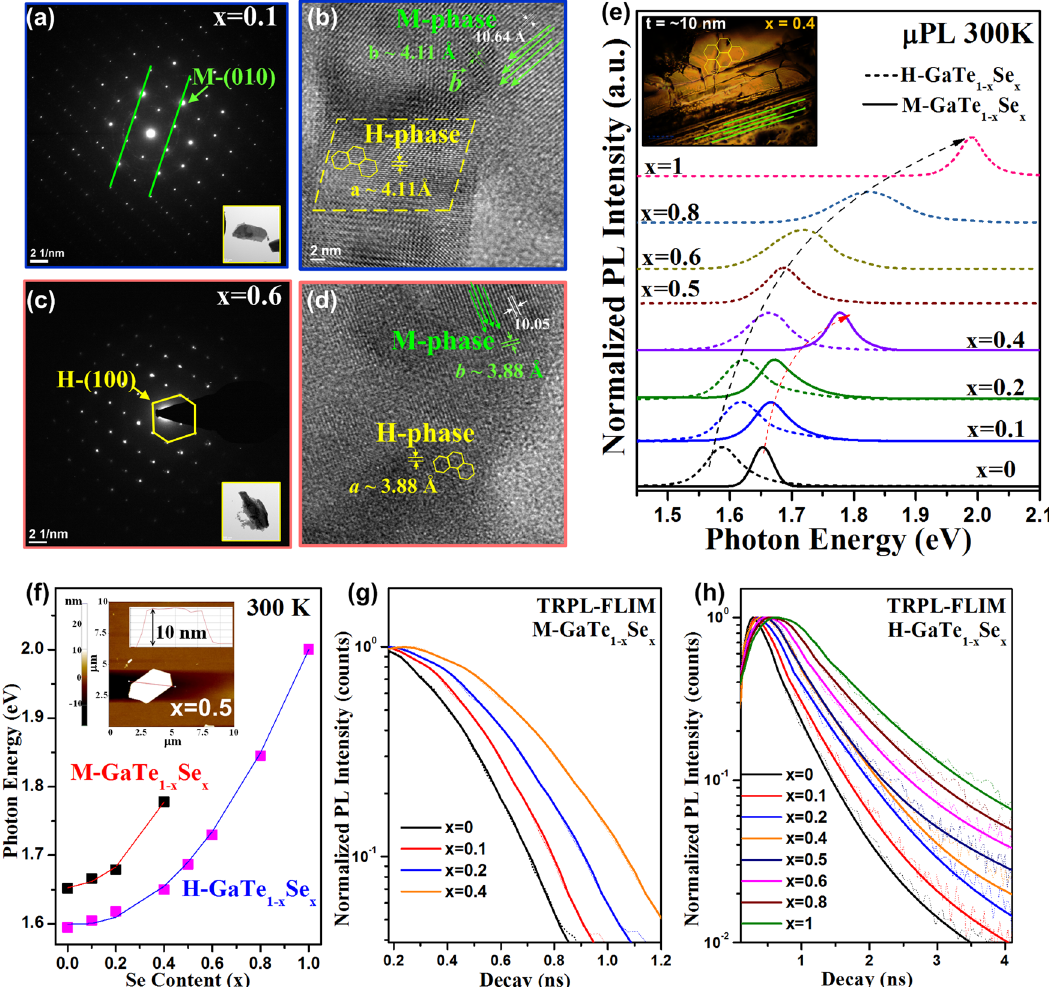
Fig. 1 Structure, μ PL and TRPL properties of M- and H-GaTe 1-x Se x . a SAED pattern and ( b ) HRTEM image of a selected few-layer GaTe 0.9 Se 0.1 . The inset shows the nano fl ake sample used for the HRTEM experiment. c SAED pattern and ( d ) HRTEM image of a selected few-layer GaTe 0.4 Se 0.6 . The inset shows the TEM image of the nano fl ake sample. e µPL spectra of each composition of GaTe 1 − x Se x from x = 0 to x = 1 that were measured for the hexagonal and monoclinic phases at 300 K. The inset shows a microscope image of a selected x = 0.4 nano fl ake ( t ≈ 10 nm) containing H- (hexagonal) and M-phase (line-edge) planes. f Composition-dependent PL peak energies of few-layer M-GaTe 1 − x Se x from x = 0 to x = 0.4 and H-GaTe 1 − x Se x from x = 0 to x = 1. The inset image shows the AFM result of a representative multilayer GaTe 0.5 Se 0.5 sample. g Analysis of the TRPL decay curves of M-GaTe 1 − x Se x from x = 0 to x = 0.4. h Analysis of the TRPL decay curves of H-GaTe 1 − x Se x from x = 0 to x = peaks for H-(002), H-(004), H-(100), H-(102), and H-(107) can be seen to have shifted down to a lower 2 θ angle as the Se content decreased, whereas some XRD peaks for M-(201), M-(401), M-(404), M-(115), and M-(312) gradually shifted up to a higher diffraction angle as the Se content increased from the GaTe end ( x = 0) toward GaSe. Except for GaSe (i.e., pure H phase), the series of GaTe 1 − x Se x (0 ≤ x < 1) layers comprised mixed phases of H and M. Essentially, the H phase was present throughout the entire series of GaTe 1 − x Se x (0 ≤ x ≤ 1) compounds and M phase may or may not have been present in the GaTe 1 − x Se x series with the existence of tellurium (i.e., x ≤ 0.8). The XRD and HRTEM results show that the Se-rich ( x ≥ 0.5) samples had predominantly the hexagonal phase, whereas the dominant phase of the Te-rich crystals ( x ≤ 0.4) was monoclinic. All the lattice constants with M and H phases of the GaTe 1 − x Se x (0 ≤ x ≤ 1) series that were obtained using HRTEM and XRD are compared and listed in Supplementary Table 1. The a , b , and c axes in the H- and M-GaTe 1 − x Se x are indicated in Fig.1a – d, in which the layer-by-layer distance of the van der Waals . gap of the H phase is d (002) and that of the M phase is d ð 201 Þ